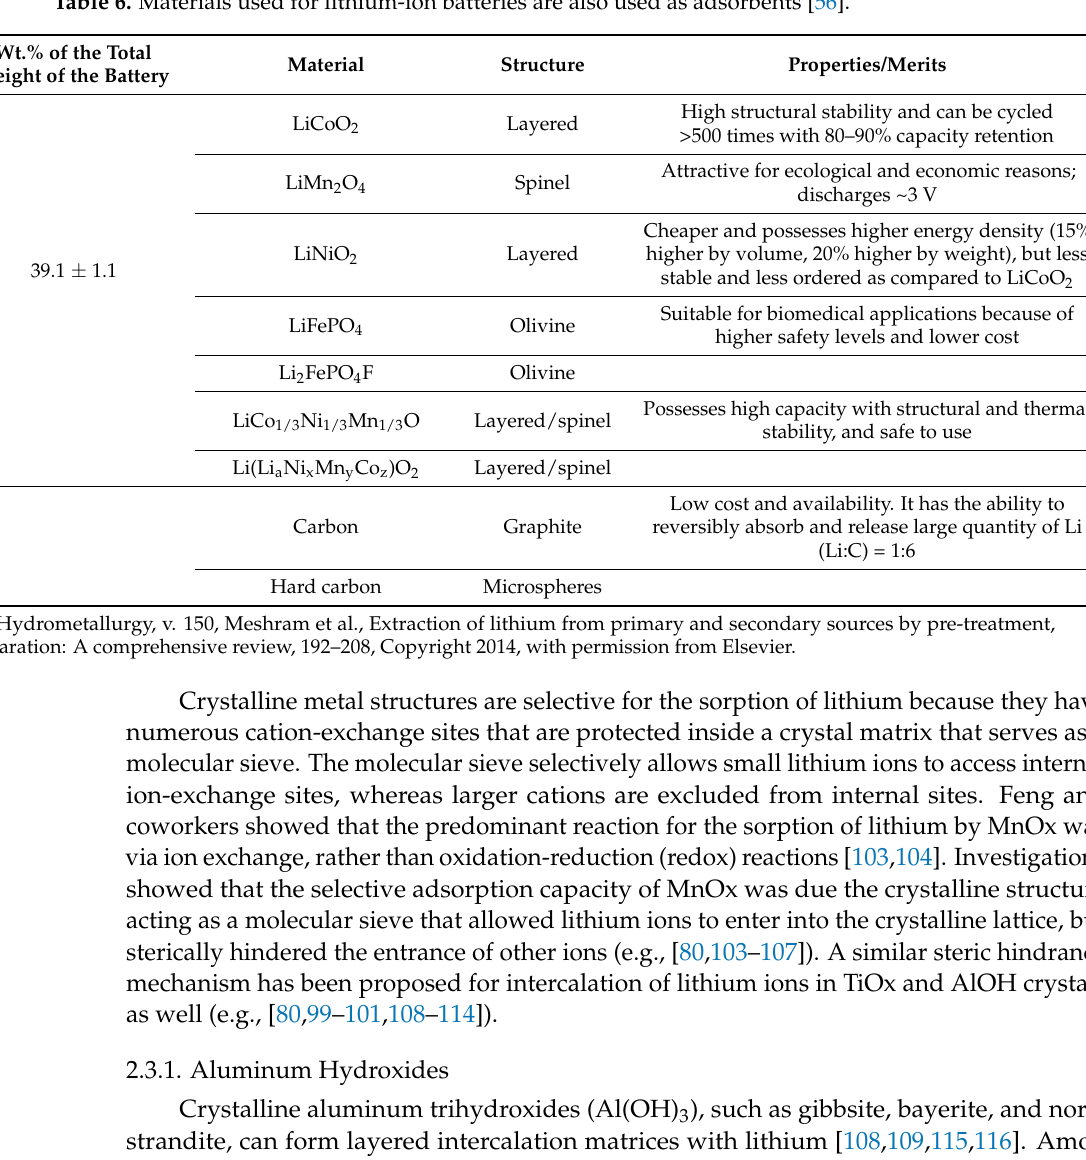
Table 6. Materials used for lithium-ion batteries are also used as adsorbents